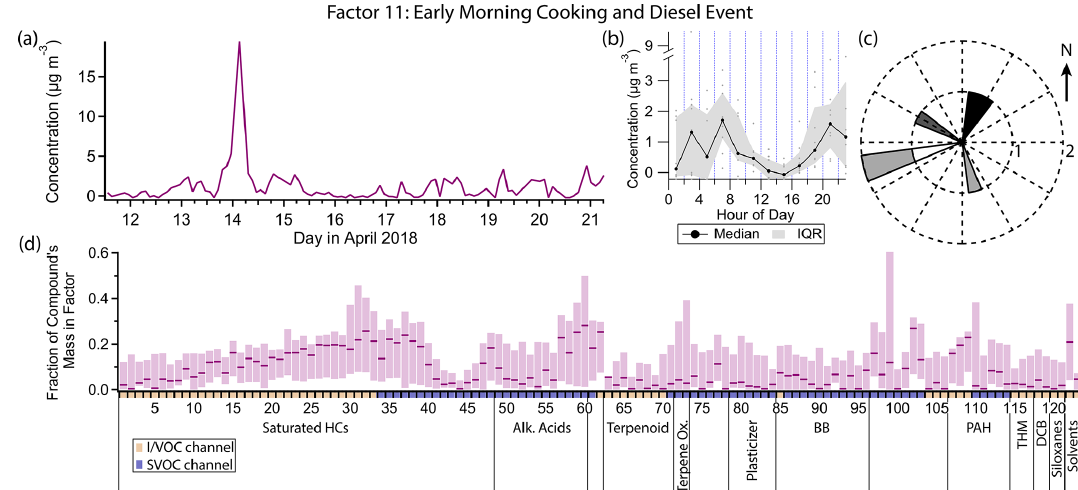
Figure 16. (a) Factor 11 timeline. (b) Diurnal profile for Factor 11. (c) Rose plot showing correlation of elevated emissions and wind direction. (d) Factor 11 composition profile. See Fig. 4 description for further information on how to read this figure.